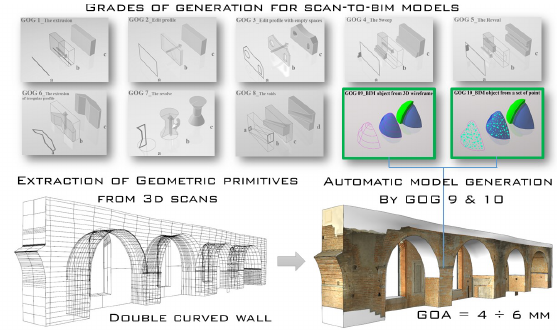
Figure 4. The application of GOG 9 and 10 for the most complex structural element of the Basilica of Sant Ambrogio.